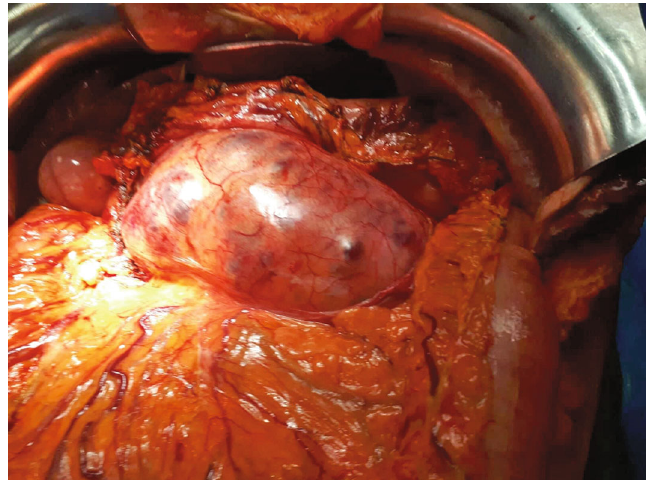
Figure 2: Operative fi eld after the section of gastrocolic